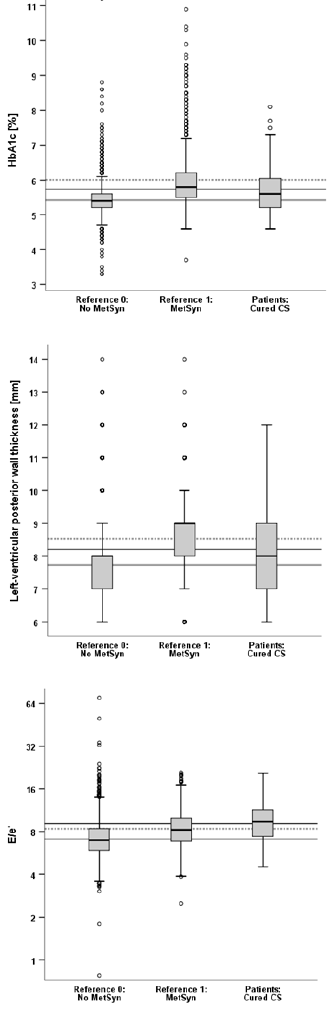
Figure 2. Boxplots of HbA1c, left ventricular posterior wall thickness, and the left ventricular inflow velocity to left ventricular relaxation velocity ratio E/e’ in the reference samples and in the patient sample of interest for example 2. The horizontal lines represent the overall non-stratified means (gray solid line, gray dotted line, and black line, respectively). MetSyn: metabolic syndrome, CS: Cushing’s